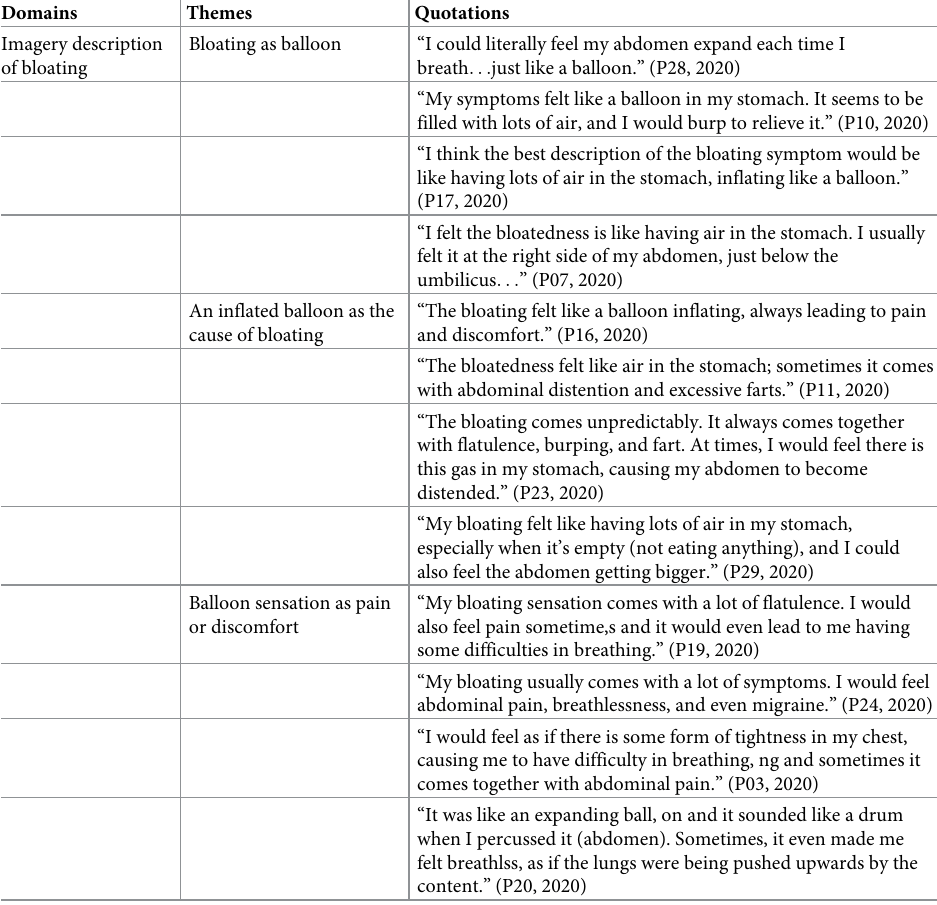
Table 1. Results of imagery description of bloating from the in-depth